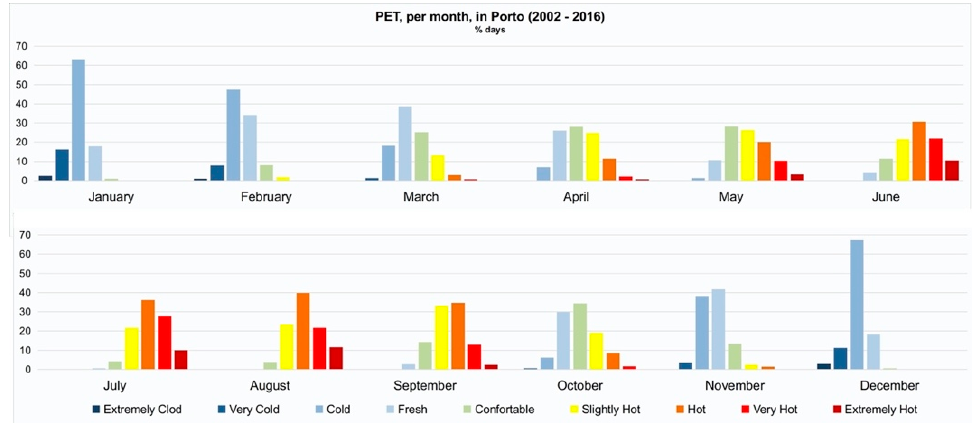
Figure 3. Physiological Equivalent Temperature (PET) at Porto from 2002 until 2016 [31].